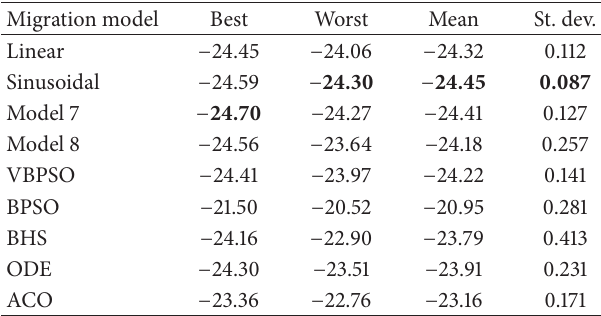
Table 4: Comparative results for 300-element symmetric thinned array with same aperture size. The smaller values are in bold. Migration model